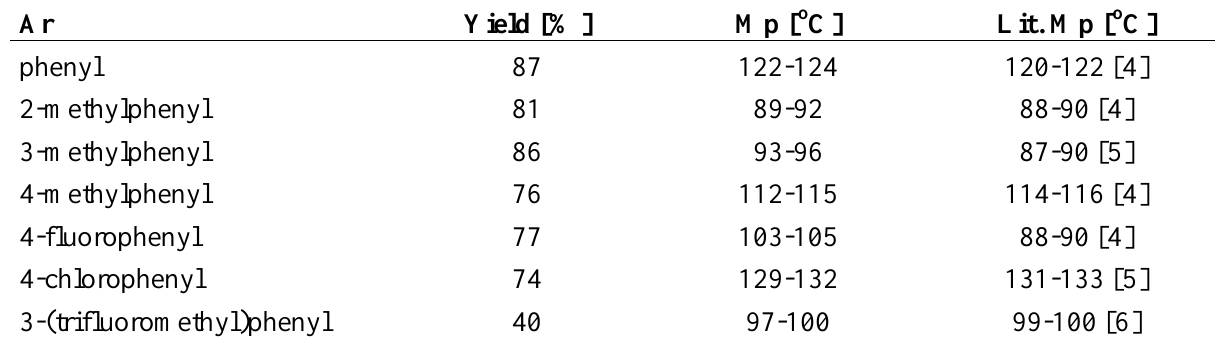
Yields and melting